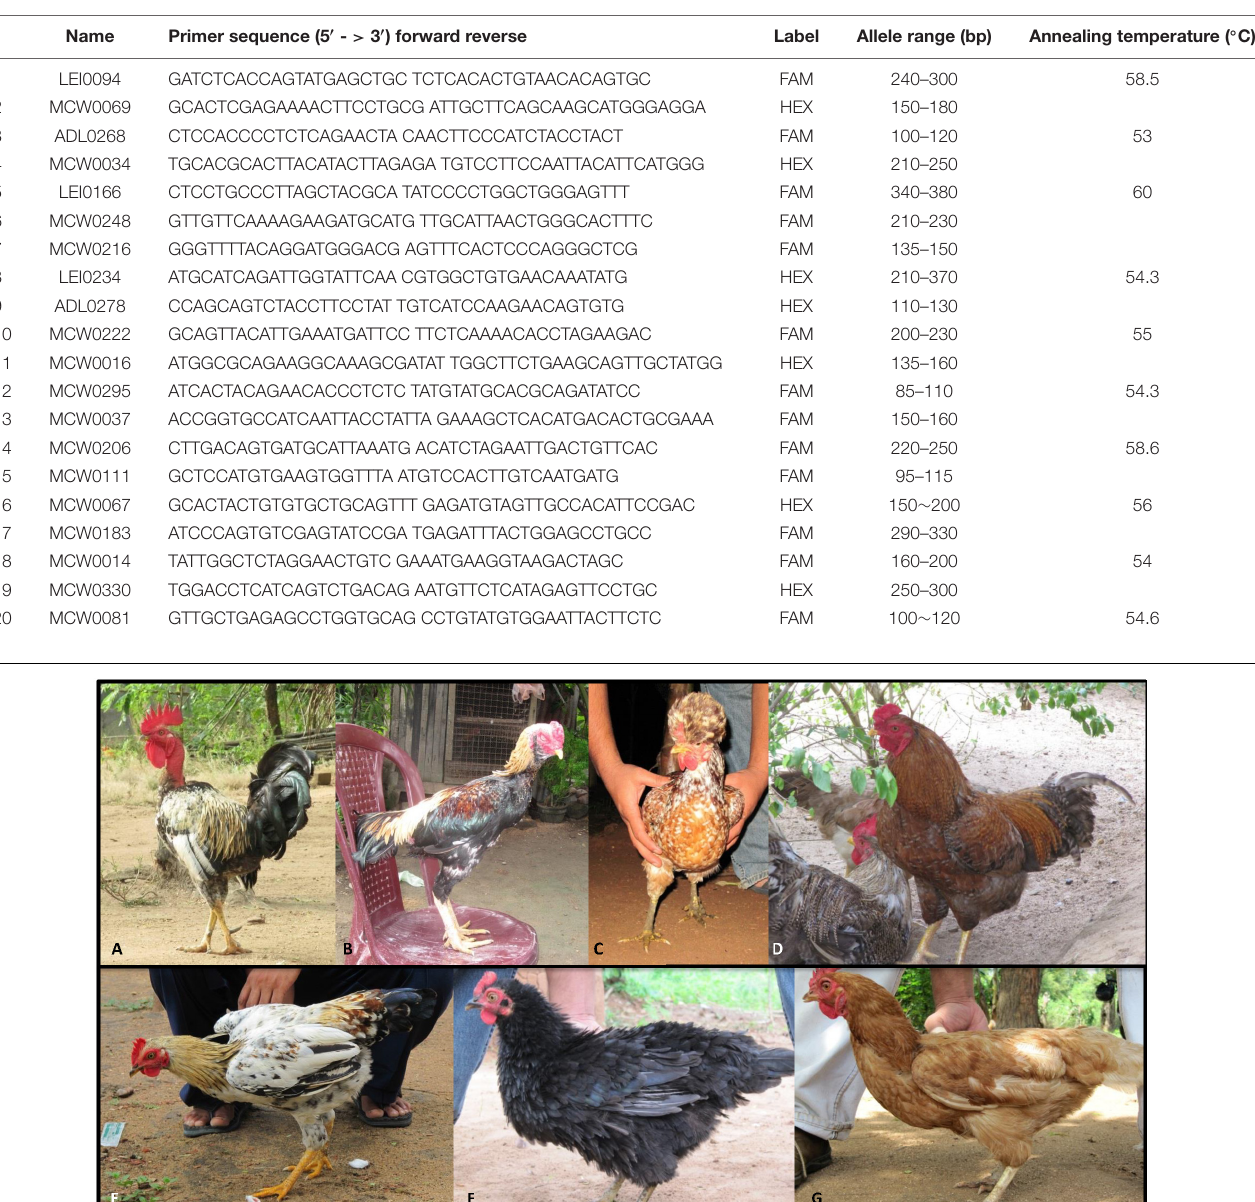
quantity ( (cid:49) K ) based on the rate of change in the log probability of data between successive K values was calculated to verify the best K using the web-based STRUCTURE HARVESTER (Earl,